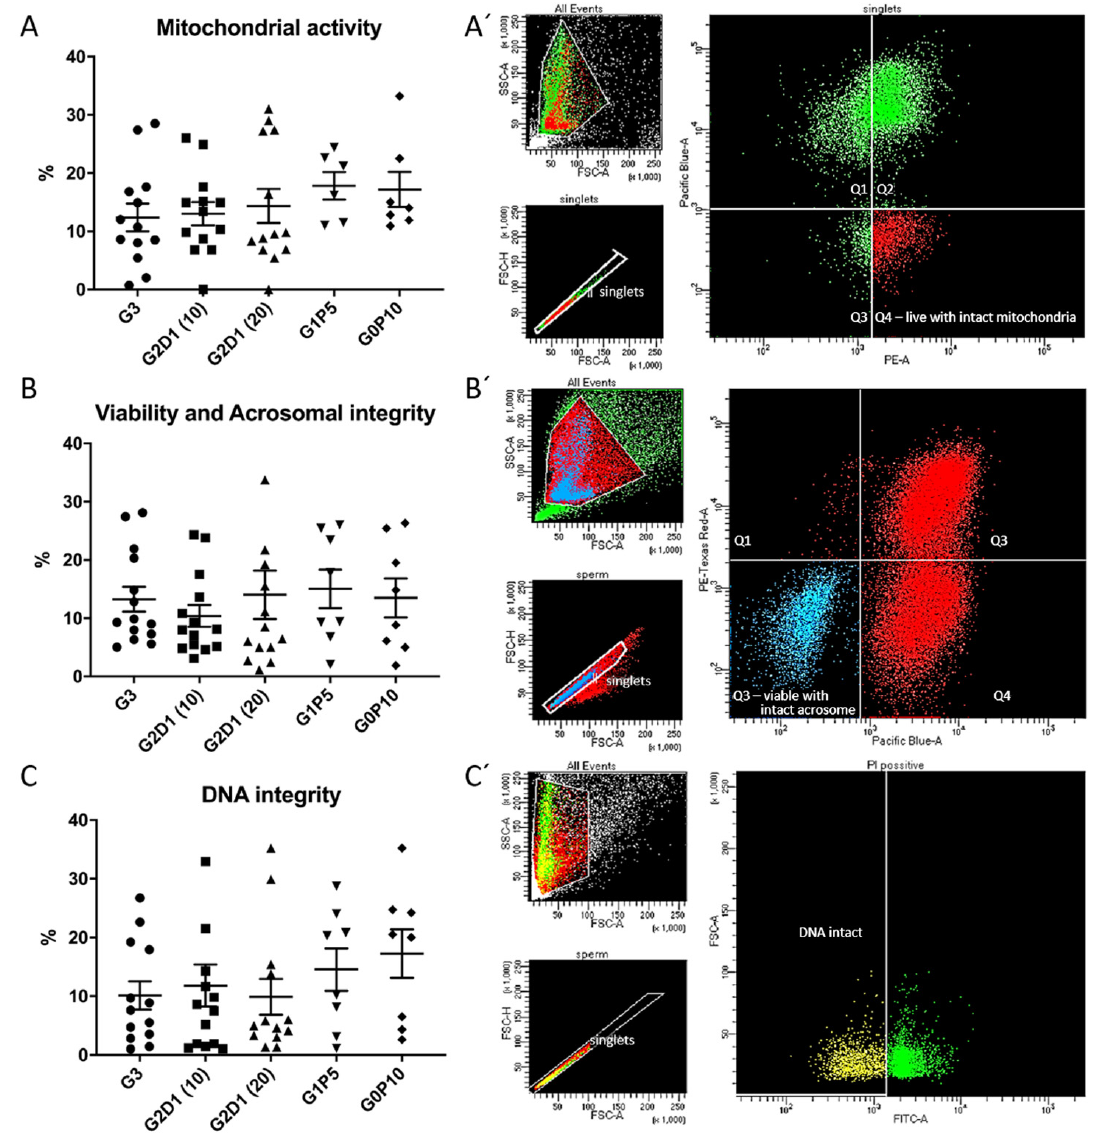
visible in Figure 4C.